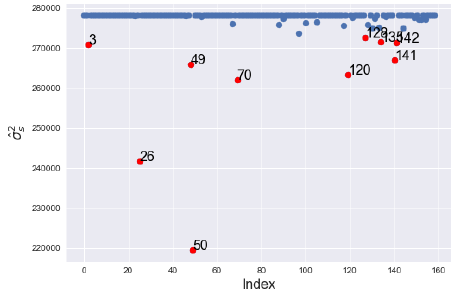
, ( b ) ˆ ω si for the Geogia COVID-19 data. si